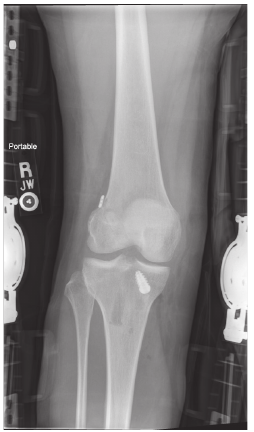
Figure 3: Immediate ACL reconstruction postoperative radiographs in AP